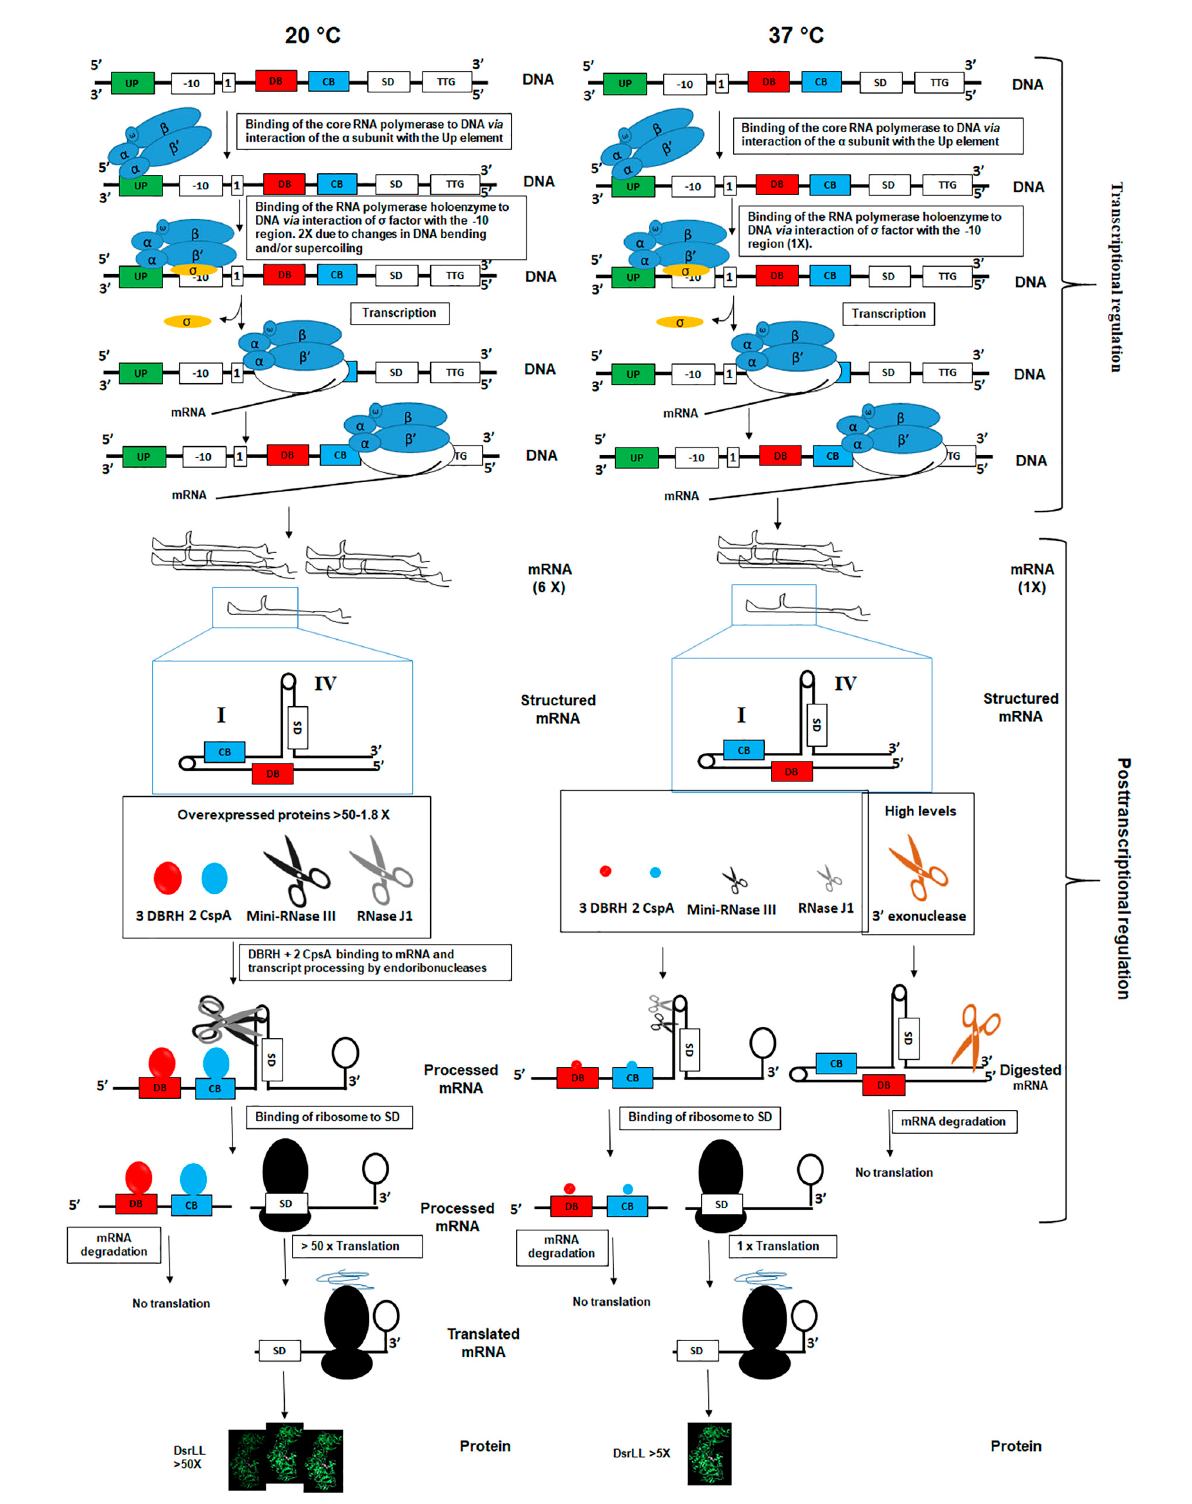
FIGURE7 Model of transcriptional and post-transcriptional regulation of dsrLL gene expression in Lc. lactis at 20 ◦ C and 37 ◦ C. The influence of DNA bending and supercoiling at the two temperatures on the efficient utilization of promoter by RNA polymerase are indicated. Also, influence of mRNA folding vs. 3 DBRH and 2 CspA binding as well as ribonucleases binding and catalysis in the fate and turnover of the transcript at 20 ◦ C and 37 ◦ C are